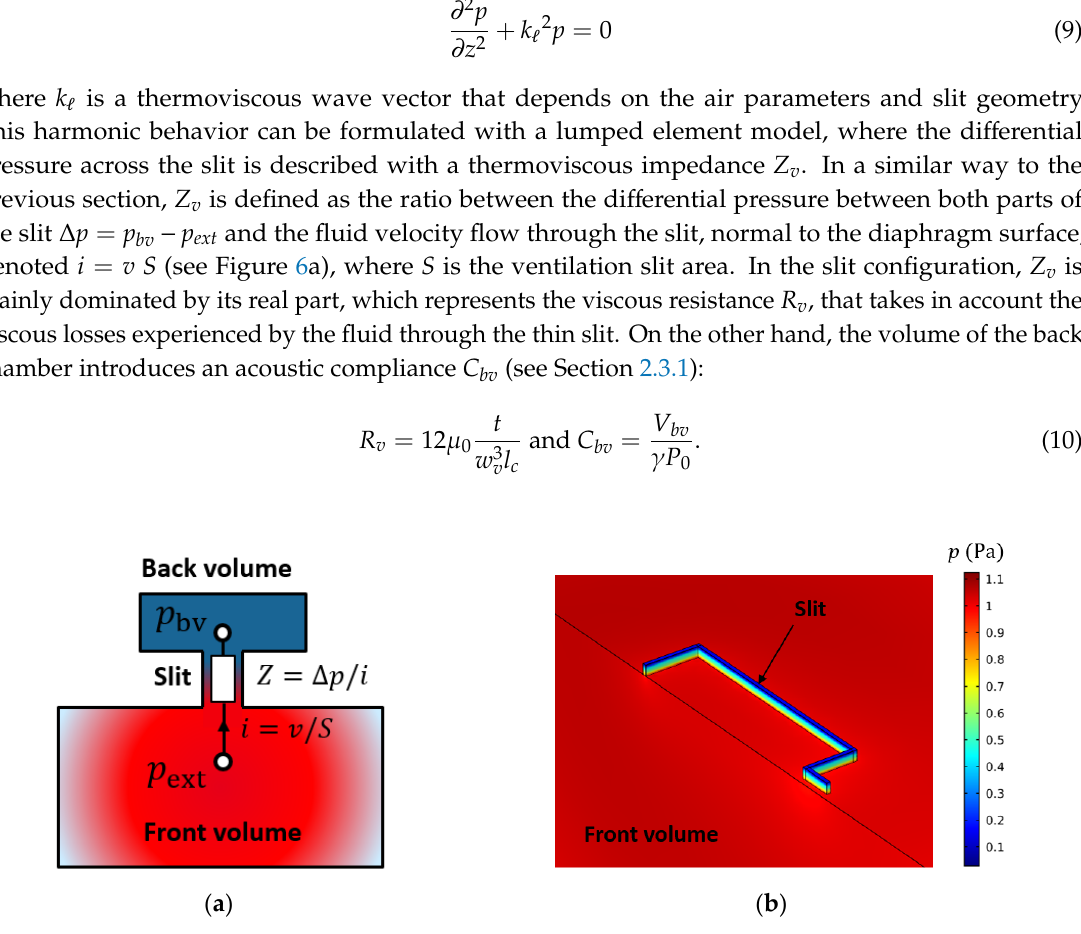
Figure 6. ( a ) Sectional schematic of the slit problem; ( b ) Pressure behavior inside the slit and the front volume for a slit length of 100 µm with 𝑝 (cid:3032)(cid:3051)(cid:3047) = 1 Pa (the mechanical structure and the back volume are not shown for the sake of clarity).